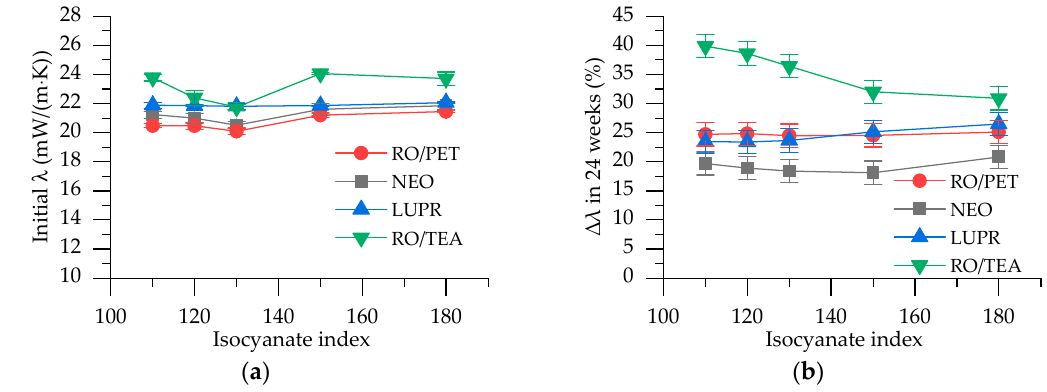
Figure 7. Results of thermal conductivity: ( a ) Initial thermal conductivity; ( b ) Thermal conductivity relative change in 24 weeks